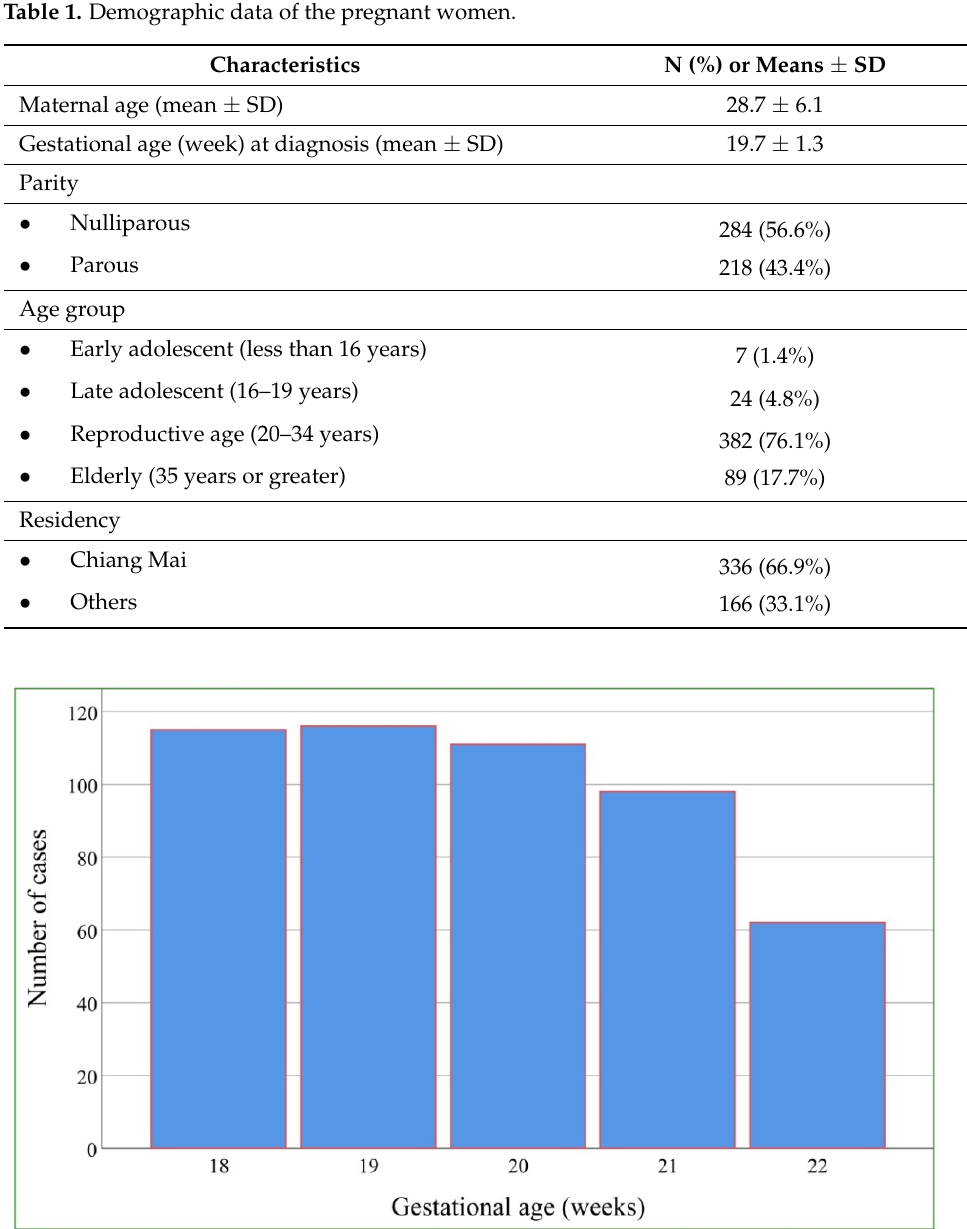
Table 1. Demographic data of the pregnant women.